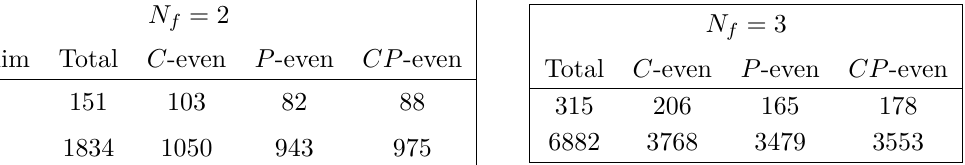
Table 9 . Enumeration of operators in the chiral Lagrangian broken down by behaviour under C , P , and CP transformations, for the cases of N f = 2 and N f = 3 light quark flavours. In contrast to table 8, ‘anomalous’ terms which involve an (cid:15) µνρσ are not separated out, and are included in the enumeration. Note that CP -even counts both C -even P -even and C -odd P -odd operators. relevant cases N = 2 , 3 . The number of P -even and P -odd operators are roughly f